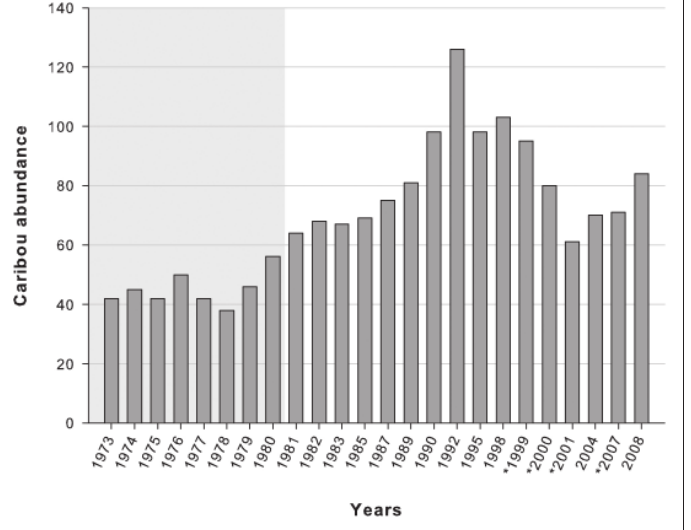
Fig. 2. Variation in abundance of the reintroduced caribou herd estimated from aerial surveys conducted in Charlevoix between 1973 and 2008. An asterisk (*) identifies years when caribou abundance was estimated rather than counted by aerial